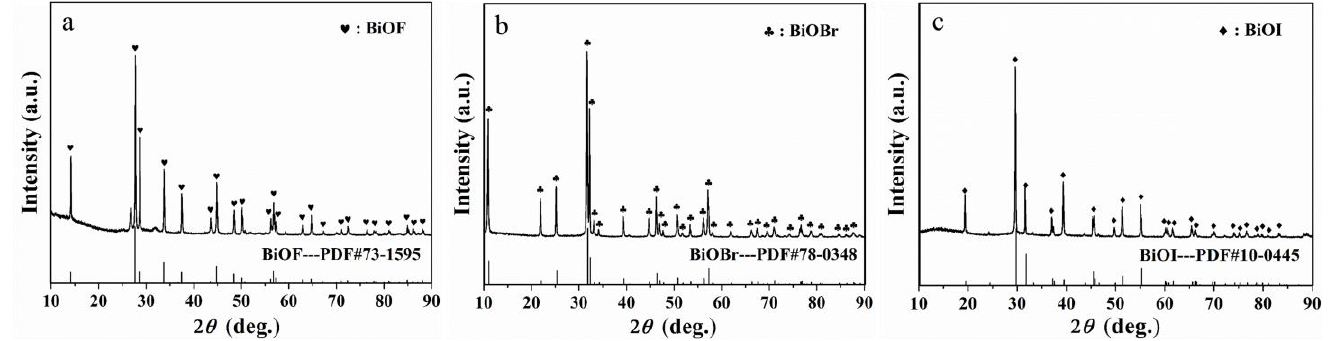
Figure 1. XRD patterns of ( a ) BiOF, ( b ) BiOBr and ( c ) BiOI.